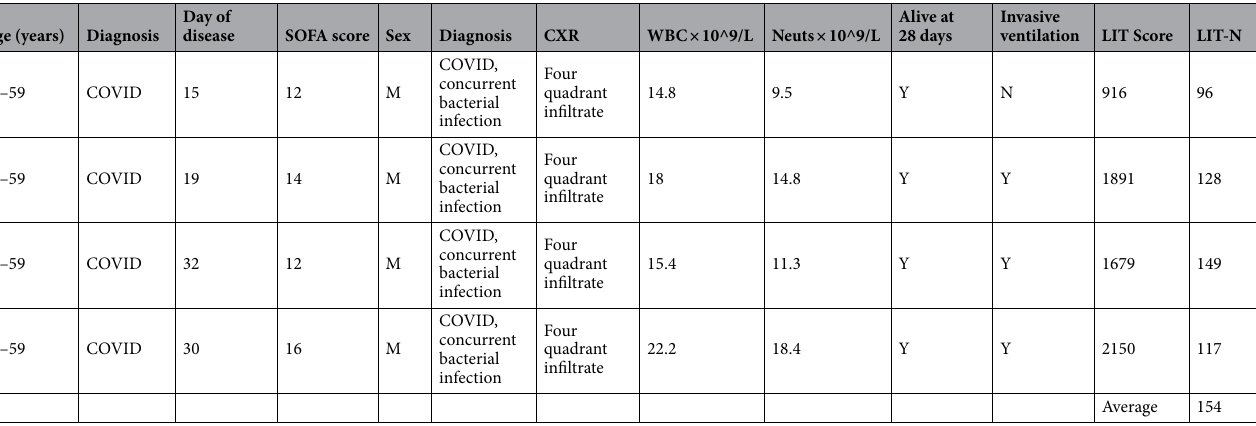
Table 1. Clinical characteristics of patient